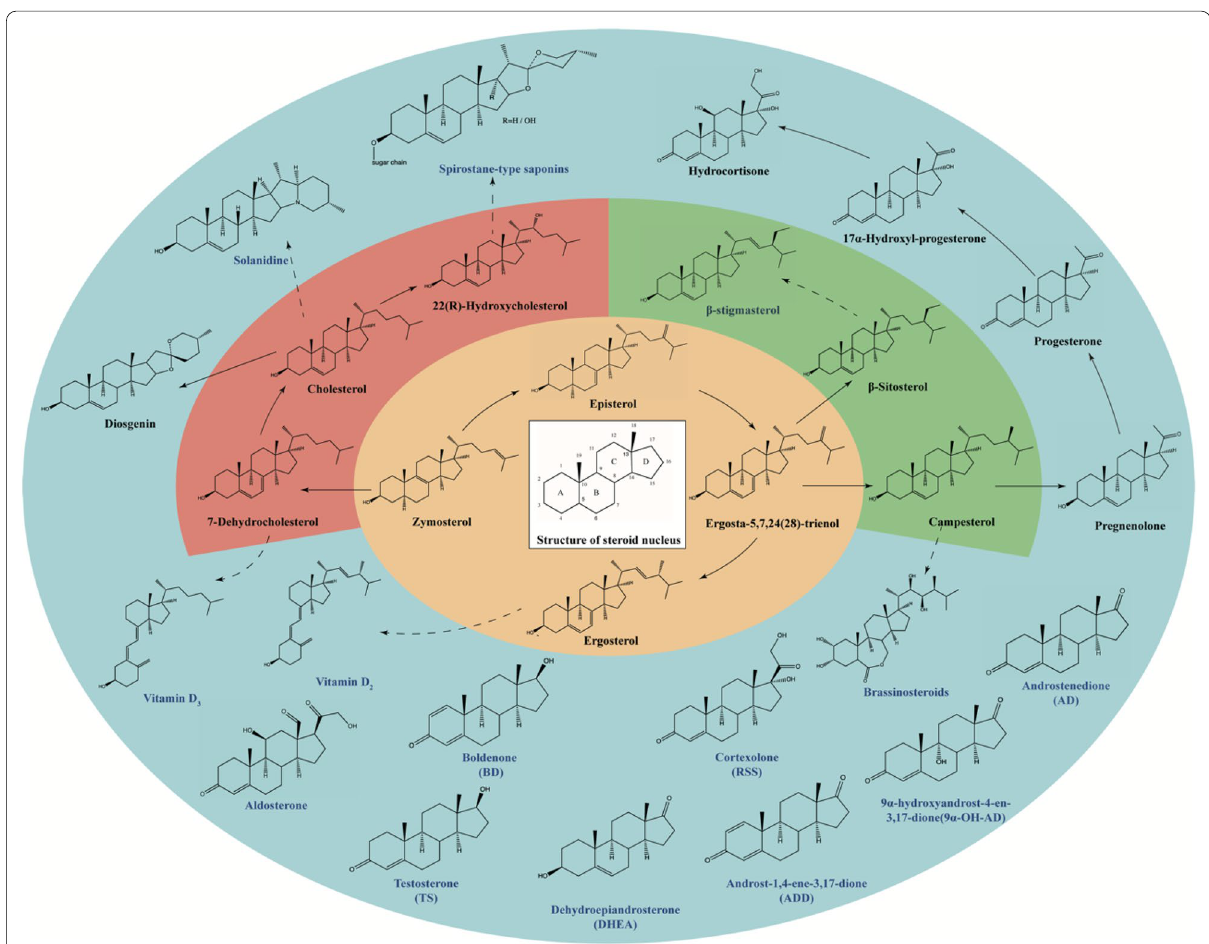
Fig. 1 Examples of sterols and steroids. The endogenous sterol pathway in yeast is highlighted in yellow, heterogenous synthesis of animal-derived sterols in yeast is highlighted in red, heterogenous synthesis of phytosterols in yeast is highlighted in green and steroids derived from sterols are highlighted in blue. Solid arrows represent de novo routes examined in yeast and dashed arrows indicate potential synthetic pathways. De novo biosynthesis of the steroidal compounds marked in blue are not yet realized in